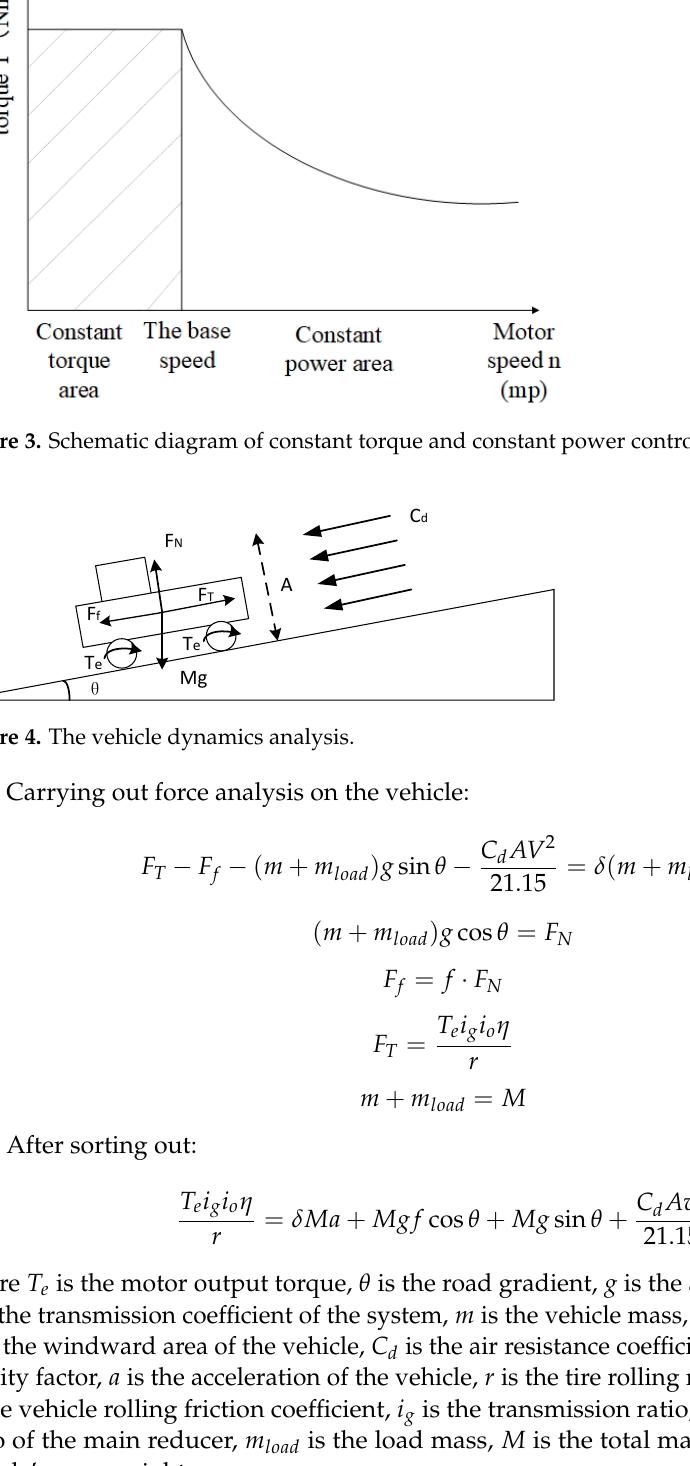
Figure 3. Schematic diagram of constant torque and constant power control process.